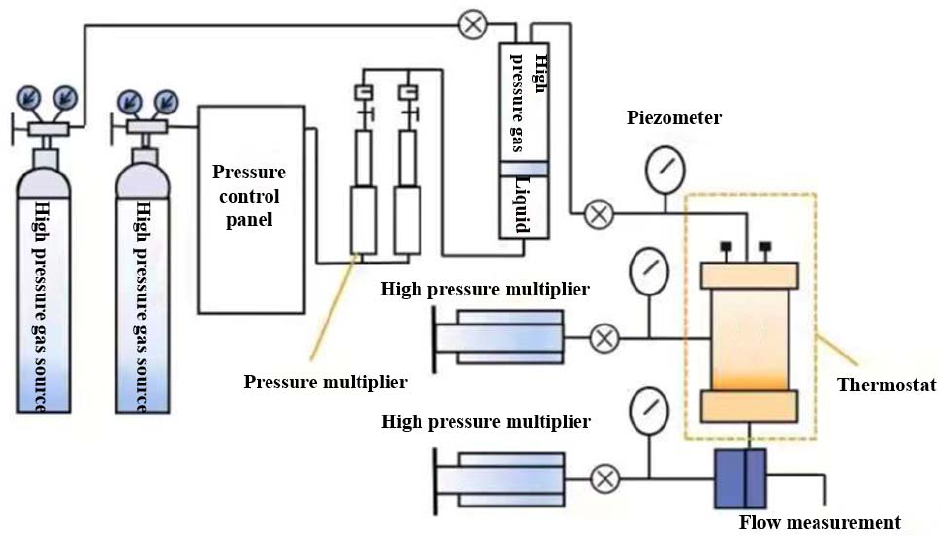
Figure 1. Diagram for experimental setup.